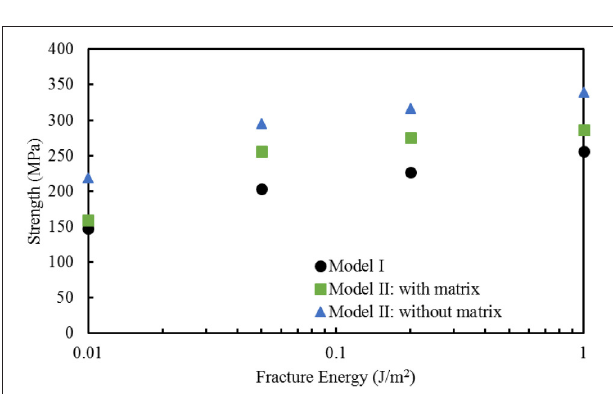
FIGURE 12 | Effect of fracture energy on the longitudinal tensile strength for different geometric models of bone. The strength of the interface is 64 MPa.